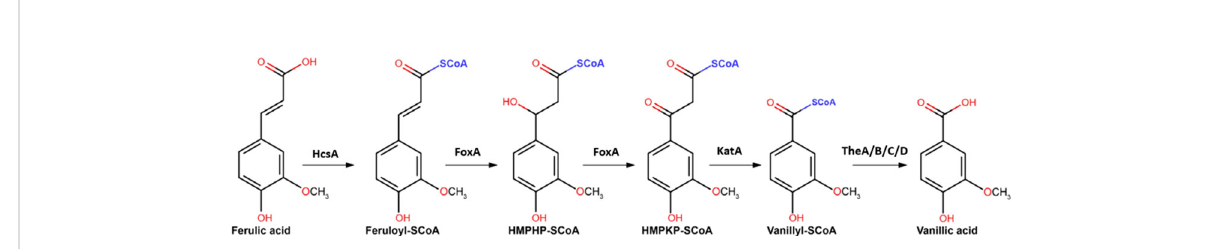
FIGURE 1 The proposed CoA-dependent b -oxidative pathway for the metabolism of ferulic acid to vanillic acid. Genes encoding the proposed enzymes include HcsA (NRRL3_05989; putative hydroxycinnamate-CoA synthase), FoxA (NRRL3_00672; putative cinnamoyl-CoA hydratase/ dehydrogenase) and KatA (NRRL3_05990; putative 3-ketoacyl CoA thiolase), and TheA-TheD (NRRL3_00621, NRRL3_01539, NRRL3_02735 and NRRL3_06009) are indicated (Figure adapted from Lubbers et al.,